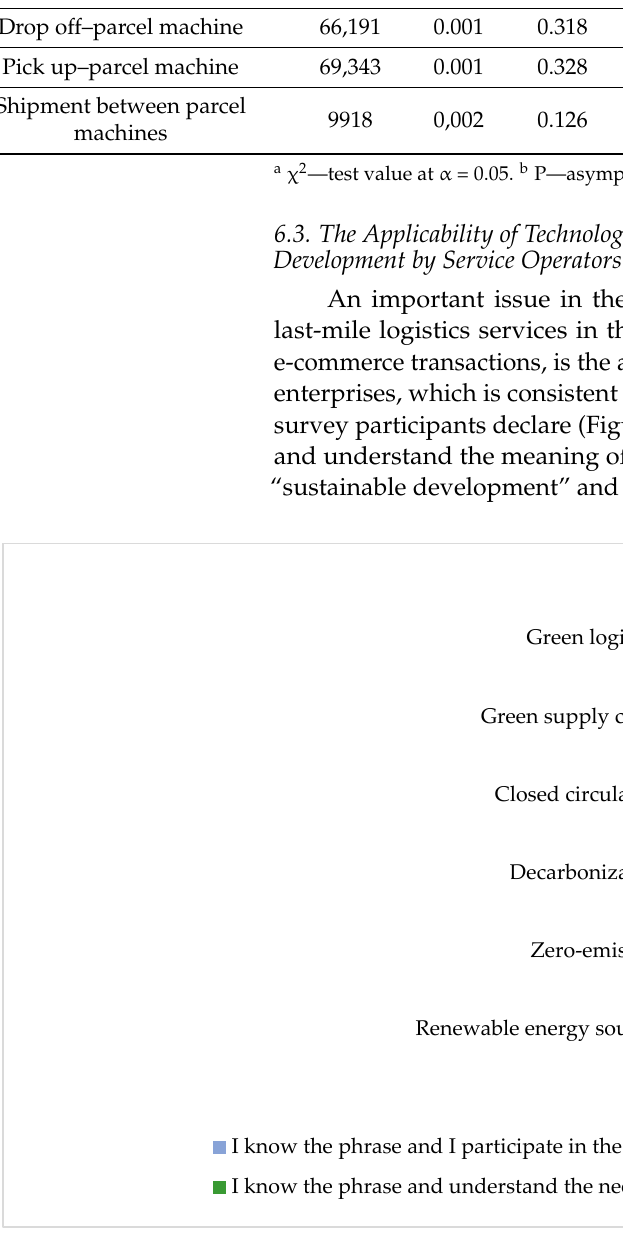
Table 5. Representation of the concept of sustainable development in relation to forms of environ- mental activities as represented by the results of a χ 2 independence test.